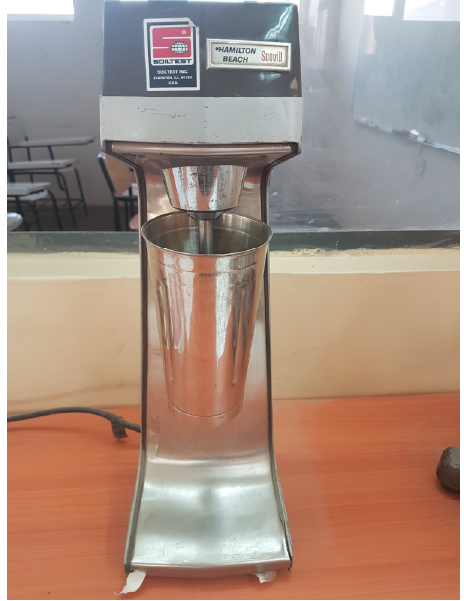
Fig. 3. Mechanical Mixer (Brabender